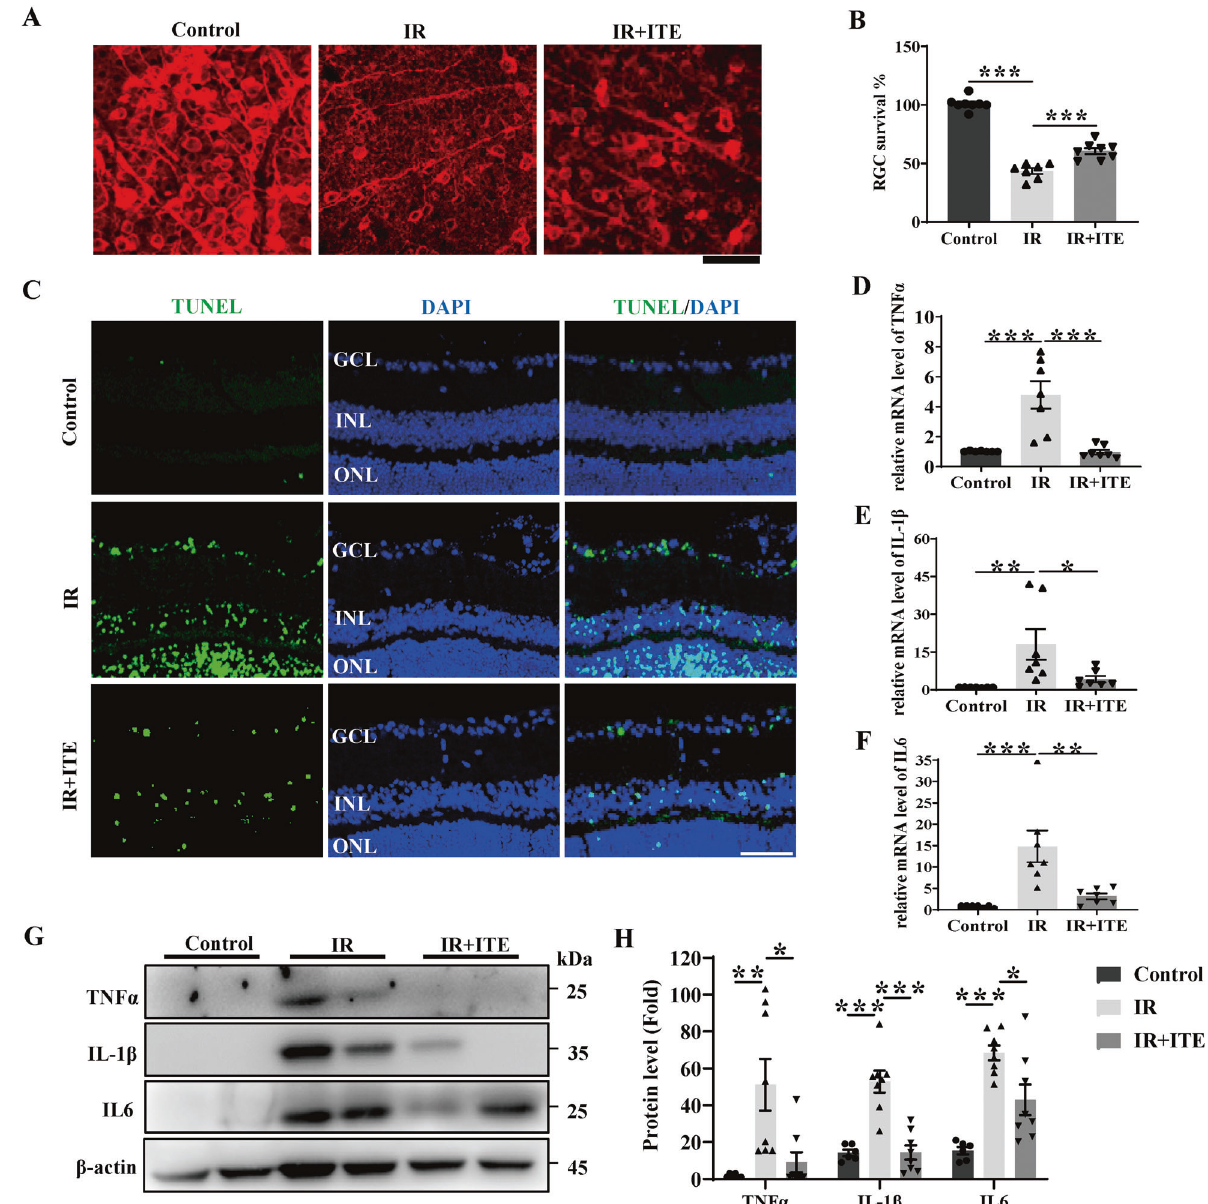
Fig. 2 Tryptophan metabolite ITE alleviated retinal injury and ameliorated retinal in fl ammation state in IR mice model. Retinal ischemia/ reperfusion injury model was established with or without ITE (10 mg/kg) daily intraperitoneal injection, and mice were euthanatized after 7 days or 1 day for RGC survival investigation or 1 day to detect the expression of in fl ammatory cytokines. A Retinal fl at mounts from Control, IR and IR + ITE groups at day 7 to detect β -III-tubulin (red) positive RGCs by immuno fl uorescence staining. B Histograms showing quantitation of RGC survival percent in each group. C Apoptosis of the retina from Control, IR and IR + ITE groups at day 1 were detected by TUNEL (green) staining. Cell nuclei were counterstained with DAPI (blue). GCL ganglion cell layer, INL inner nuclear layer, ONL outer nuclear layer. D – F mRNA expression of TNF α , IL-1 β and IL6 at day 1 were detected by qRT-PCR in the retina from Control, IR and IR + ITE groups. G , H Western blot showing the protein expression of in fl ammatory cytokines TNF α , IL-1 β and IL6 in retinas of IR at day 1 with or without ITE administration. Control, control group; IR, ischemia/reperfusion injury; IR + ITE, IR with ITE treatment. A-B, D-H, n = 6-8 for each group; C, n = 4 for each group, scale bars: 50 μ m. All data are presented as mean ± SEM, * P < 0.05, ** P < 0.01, *** P < 0.001, P value was obtained by one way ANOVA followed by multiple comparisons. Each dot in graphs represents data from an individual retina from